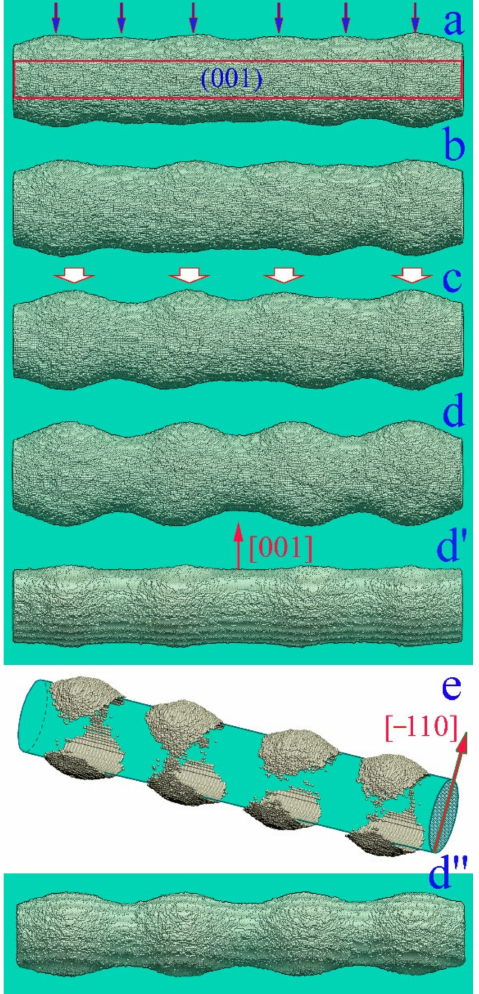
Figure 9. Surface dynamics of a nanowire with radius r nw = 45 ( r nw ≈ 18 nm for Au) under conditions of stimulated surface diffusion of atoms ((110) orientation, L = 500 ). Subparts (a-d) show the shape of the nanowire at times t = 2.25;3.00;3.90;5.10 (00 − 1)). Configuration (e) displays the atoms that have gone beyond the initial cylindrical boundary of the wire (green cylinder) for configuration (d’). Configurations (d’) and (d”) show the shape of the wire (d) from the side—when viewed along the plane (001)—at time moments t = 5.10 × 10 6 and t = 12.6 × 10 6 MC